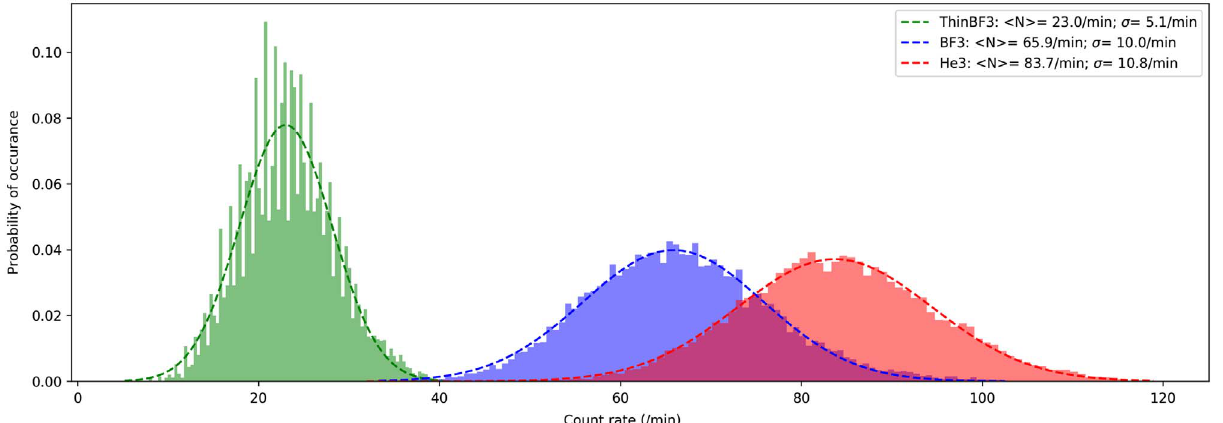
Fig. 8. Probability distribution of the count rate for each tube (histograms), fi tted with a Gaussian curve (dashed lines). The legend shows the average and standard deviation of each fi